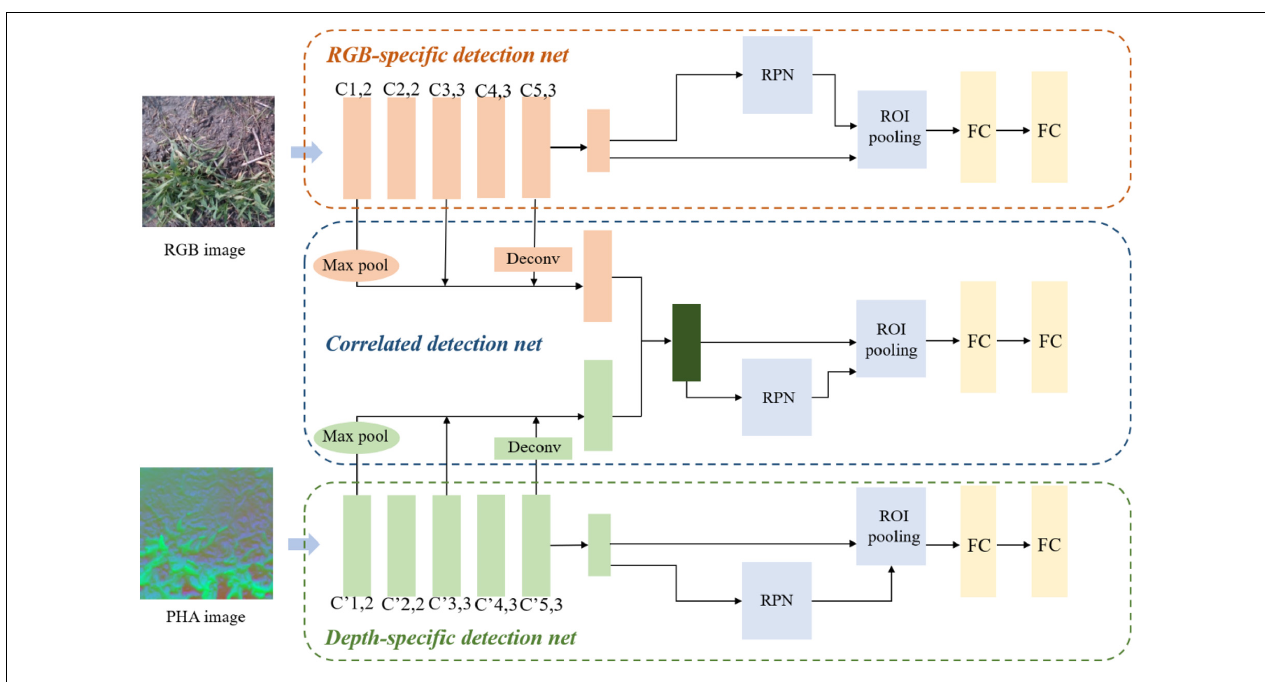
FIGURE 3 | Weeds detection network architecture.